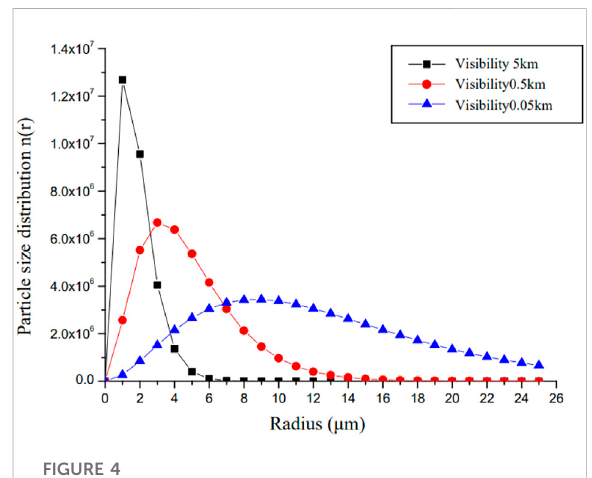
FIGURE 4 Particle size distribution in maritime fog at three different visibility levels.